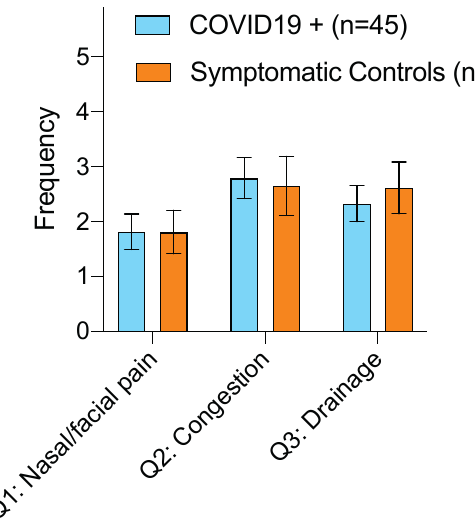
Figure S2. COVID-19 + Patients Reported Higher Frequency of Olfactory Disturbance Symptomatic Controls at Baseline. There was a signifi- cant difference in self-reported smell symptoms between COVID-19+ patients (blue) and symptomatic controls (orange). Error bars represent 95% confidence intervals. Questions are answered on a 5-point Likert scale, (1=never, 2=rarely, 3=sometimes, 4=often, 5=always). Q4: Odors smell different than I remember. Q5: My smell has been good. Q6: My sense of smell has bothered me. Q7: It has been hard for me to smell. Q8: Food has smelled good. The scores for Questions 5 and 8 were inverted for